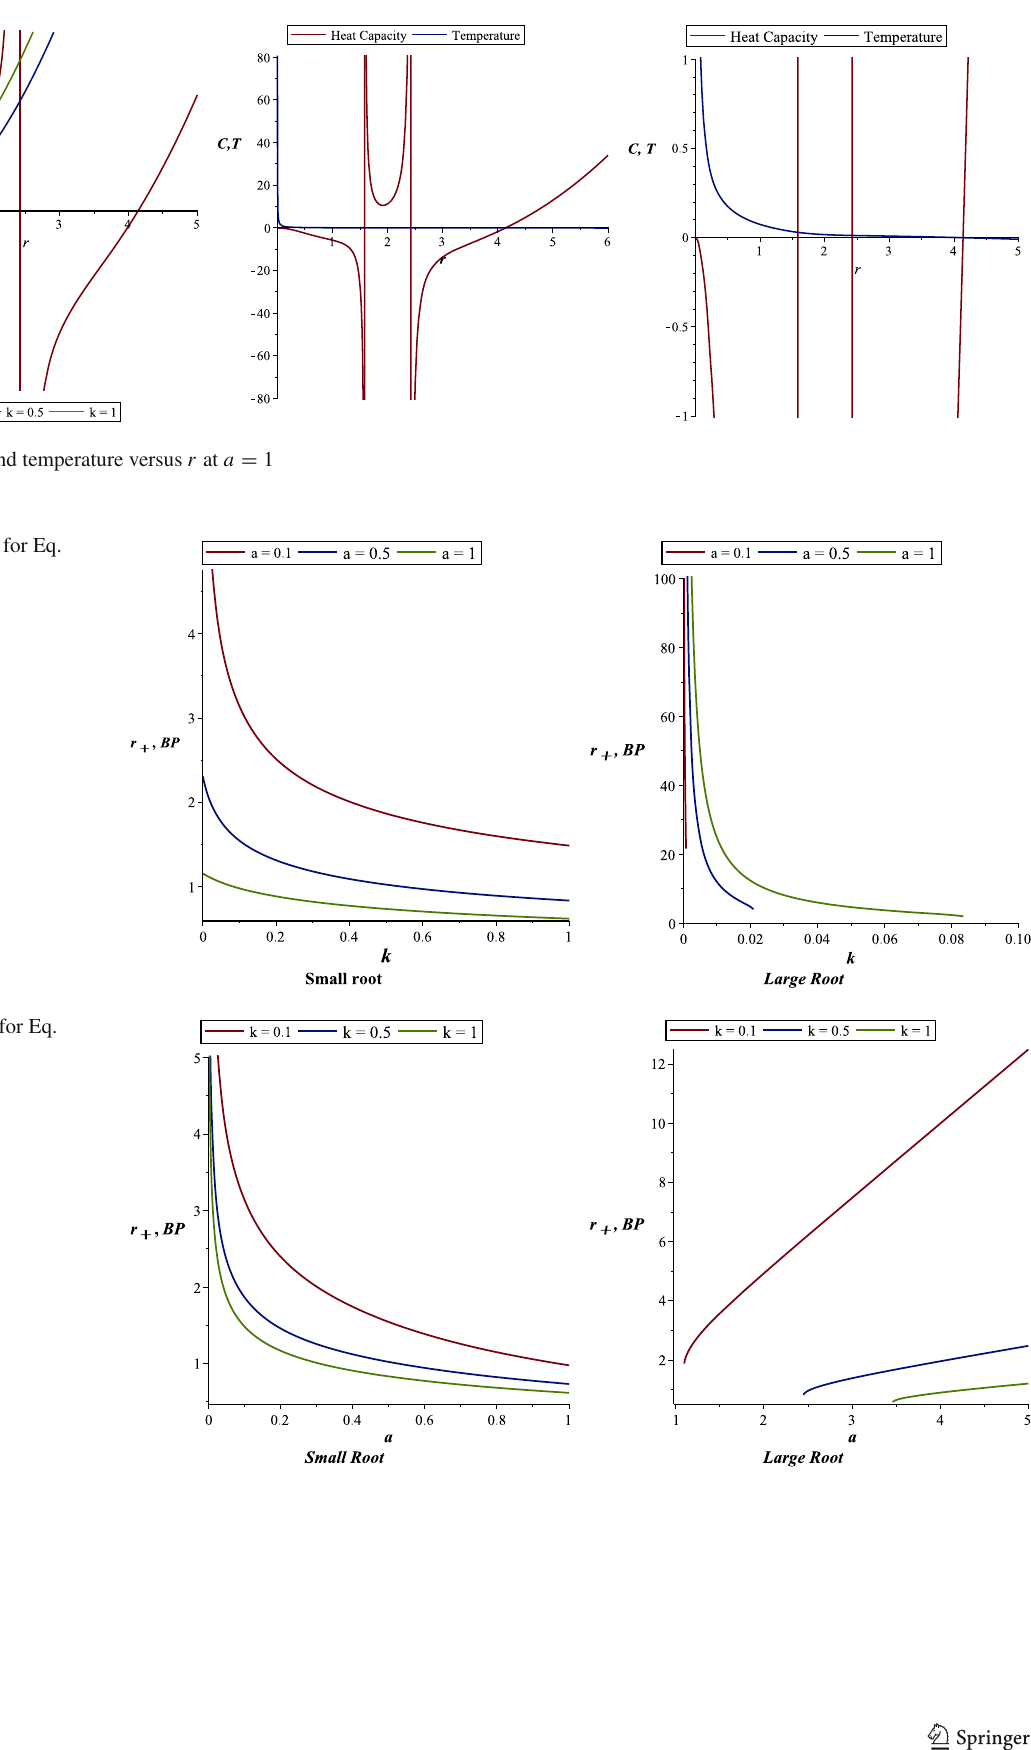
Fig. 2 Heat capacity and temperature versus r at a = 1